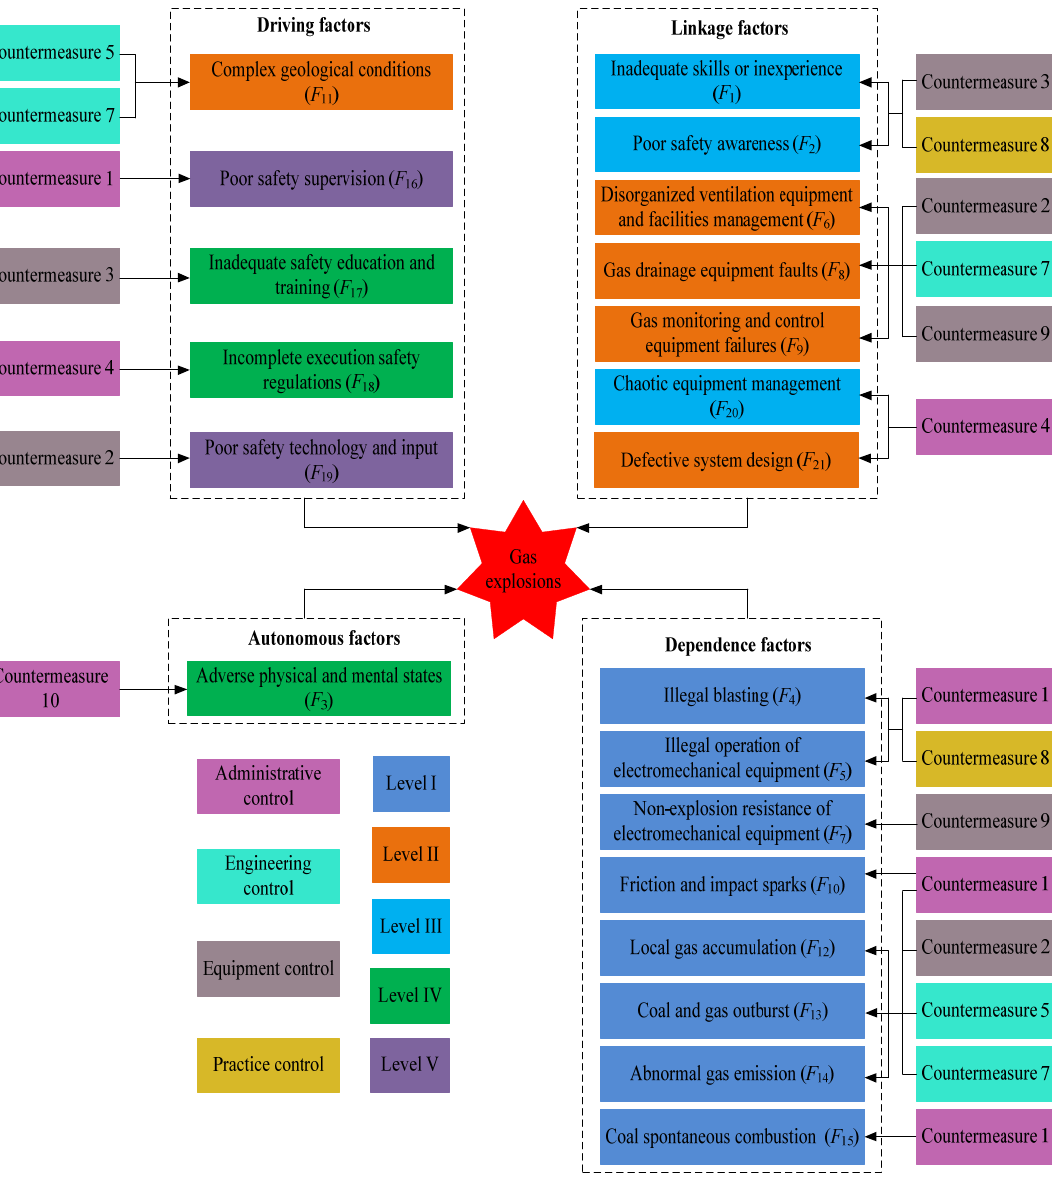
Figure 5. The representative risk factors and countermeasures.